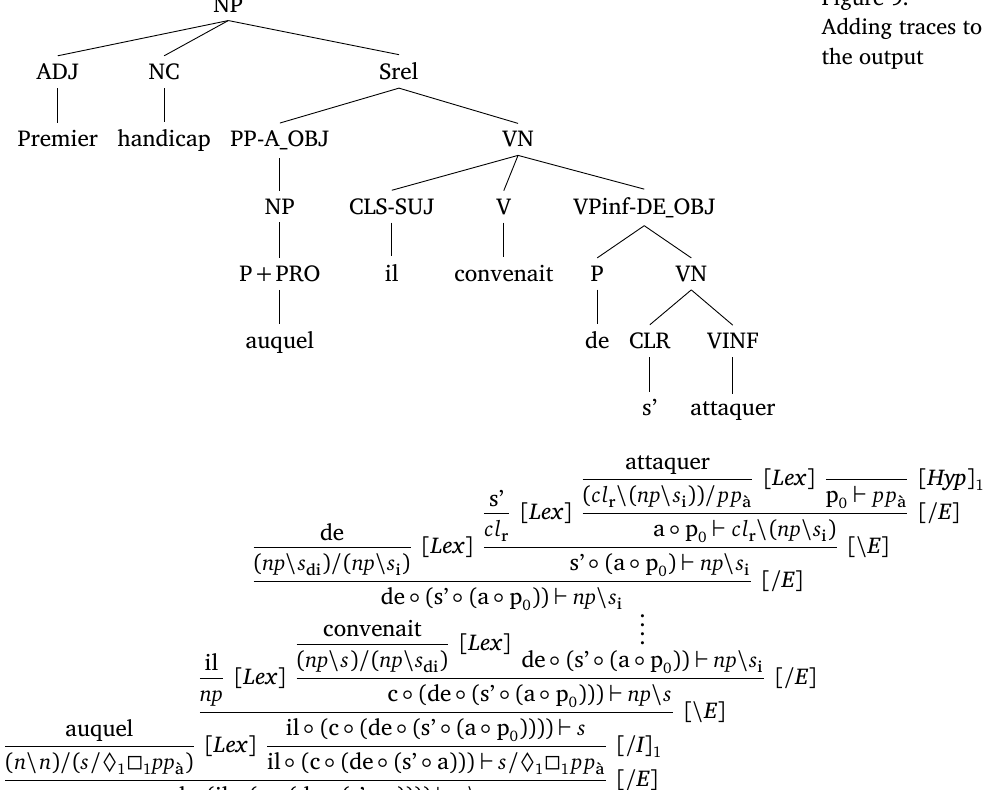
Figure 9: Adding traces to the